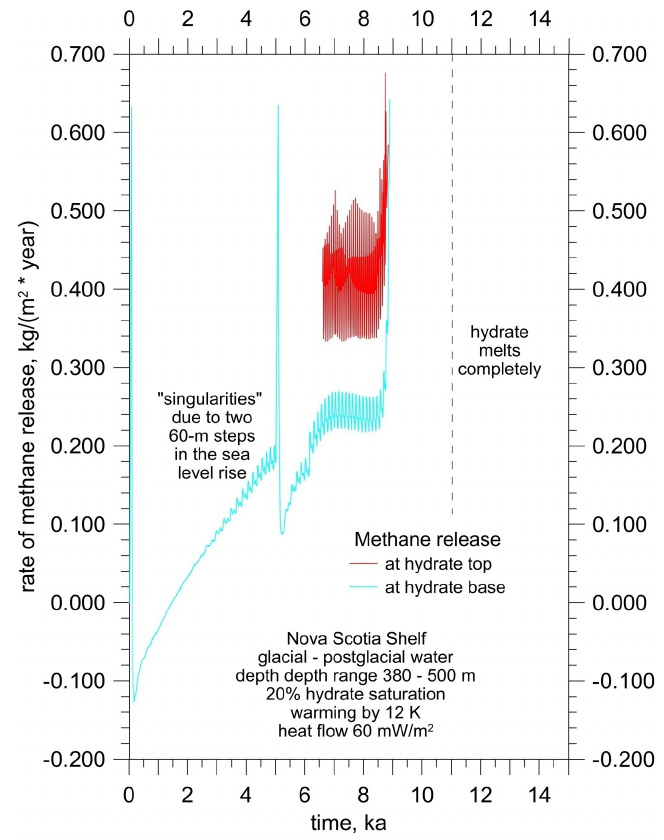
Figure 18. Model methane release rate (kg m − 2 yr − 1 ) history for the Atlantic Margin offshore for a current 380–500 m water depth. The sharp oscillations are an artifact caused by linear interpolation of temperature between the nodes of the depth grid during the numerical